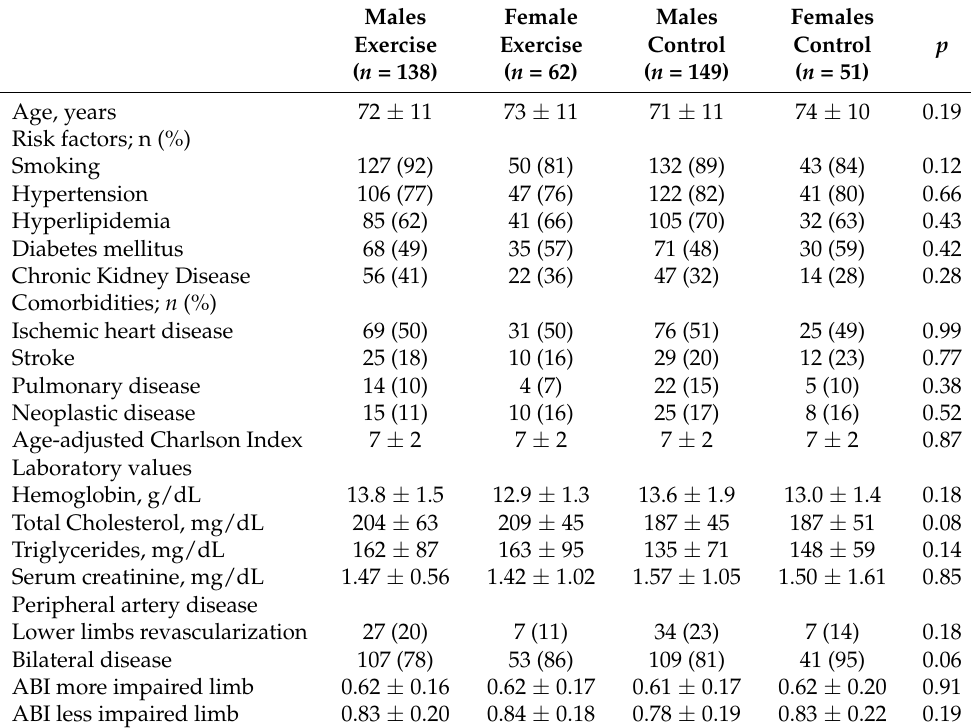
Table 1. Baseline comparison between the four study